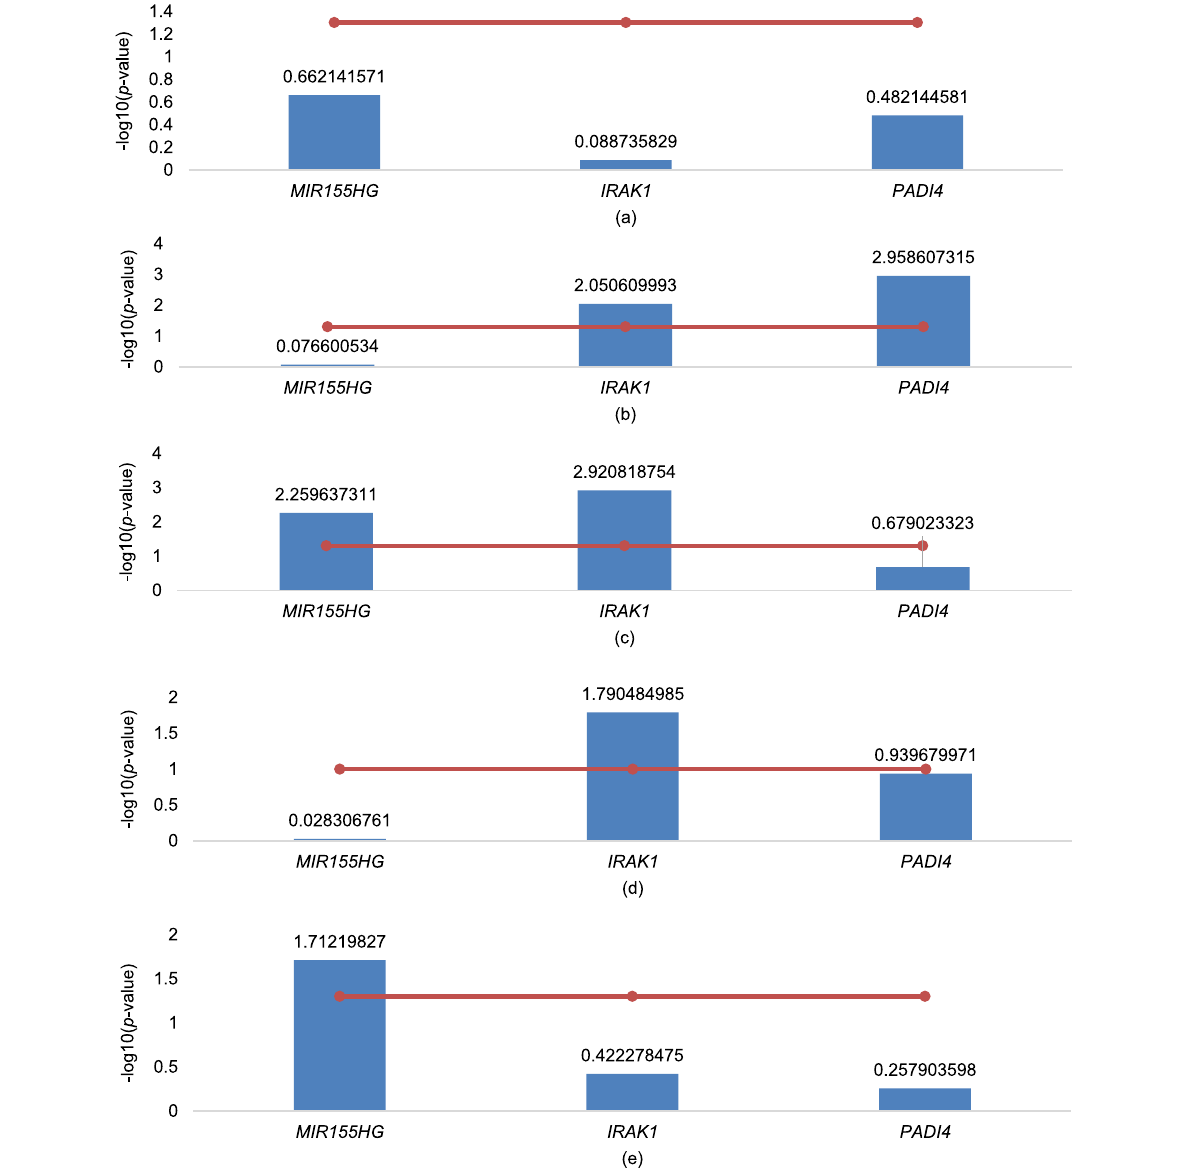
Fig. 4 Association analysis for the excluded SNPs. The horizontal line in each model represents the significance level of the p value (0.050). a Multiplicative model, b dominant model, c recessive model, d co-dominant with heterozygote model, e co-dominant with minor homozygote